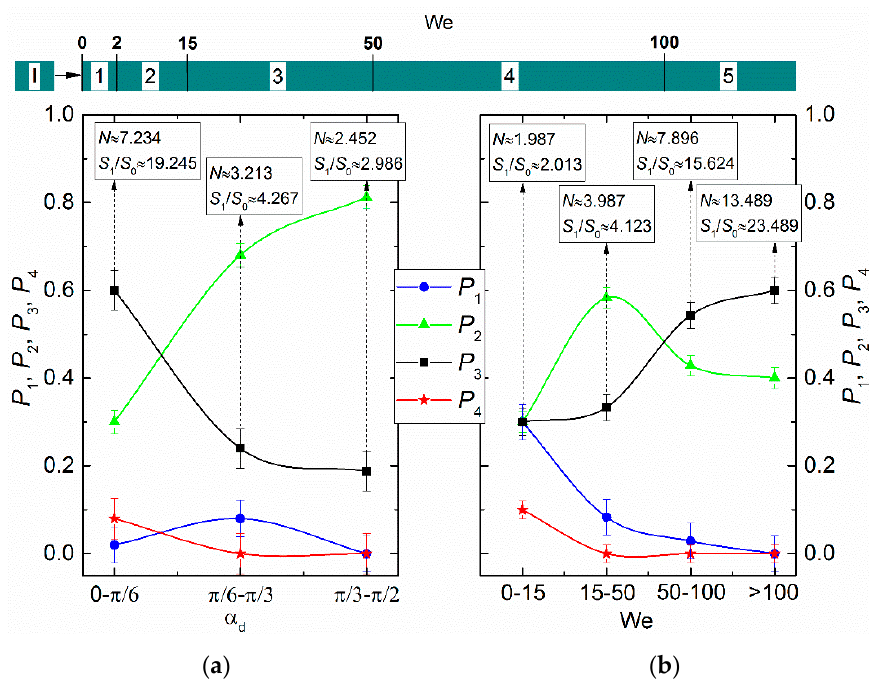
Figure 4. Frequency of each of four droplet interaction modes ( P 1 —coalescence, P 2 —separation, P 3 — disruption, P 4 —bounce) when varying impact angle (between flight trajectories) ( a ) and Weber number ( b ). Additional experimental data (I) is presented on recording different droplet collision modes at 0 < We < 200 [25,26]: 1—bounce; 2—stable coalescence; 3—coalescence with following separation; 4—separation; 5—disruption).